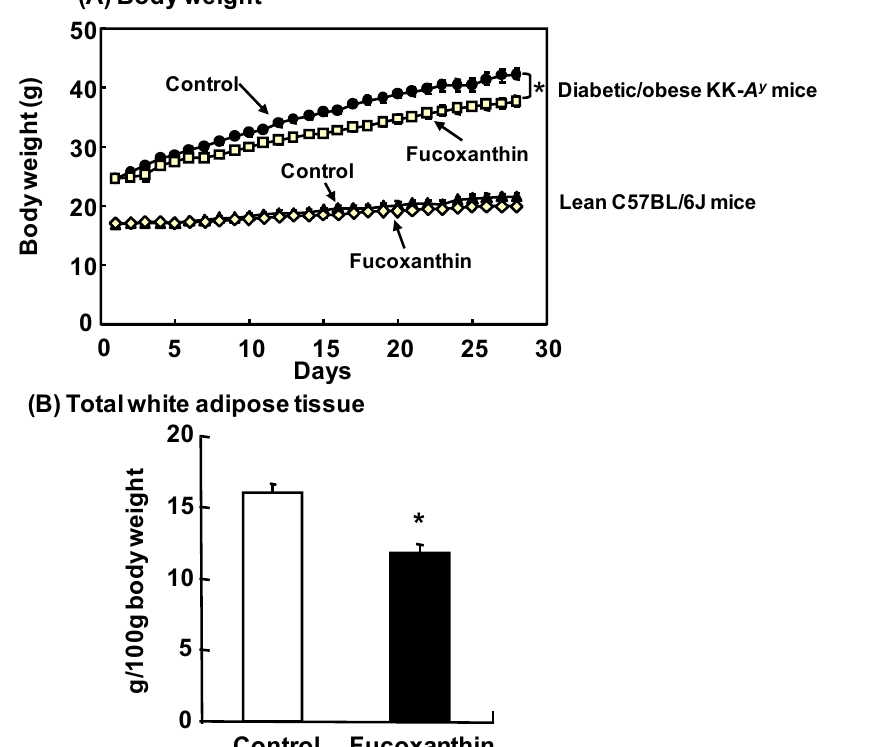
Figure 5. Anti-obesity effects of fucoxanthin on diabetic/obese mice. ( A ) Body weight of diabetic/obese KK- A y mice and lean C57BL/6J mice after four weeks of feeding of diets with/without 0.2% fucoxanthin; ( B ) White adipose tissue weight of KK- A y mice fed the diet with 0.2% fucoxanthin for two weeks. * p < 0.05 compared with